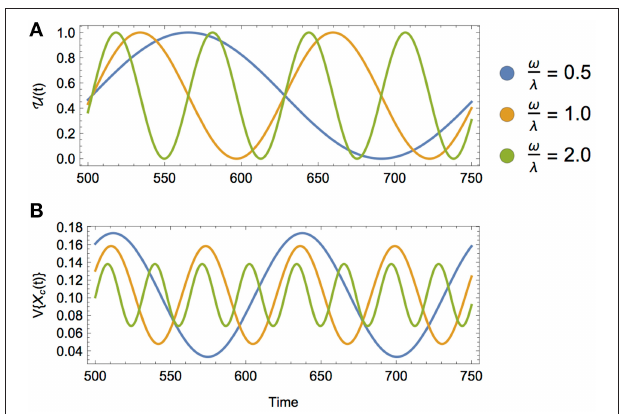
FIGURE 6 | The isotopic mixing space ( δ 13 C vs. δ 15 N ) for a sea otter 1 / 2 1 / 2 sin ( ω t ) for consumer in central California, composed of nine commonly = + consumed invertebrate species. D. Crabs, Dungeness Crabs; P. Urchins, across X c ( t ) Purple Sea Urchins; R. Urchins, Red Sea Urchins; K. Crabs, Kelp Crabs; R. { } Crabs, Rock Crabs. Units are per-mil ( h